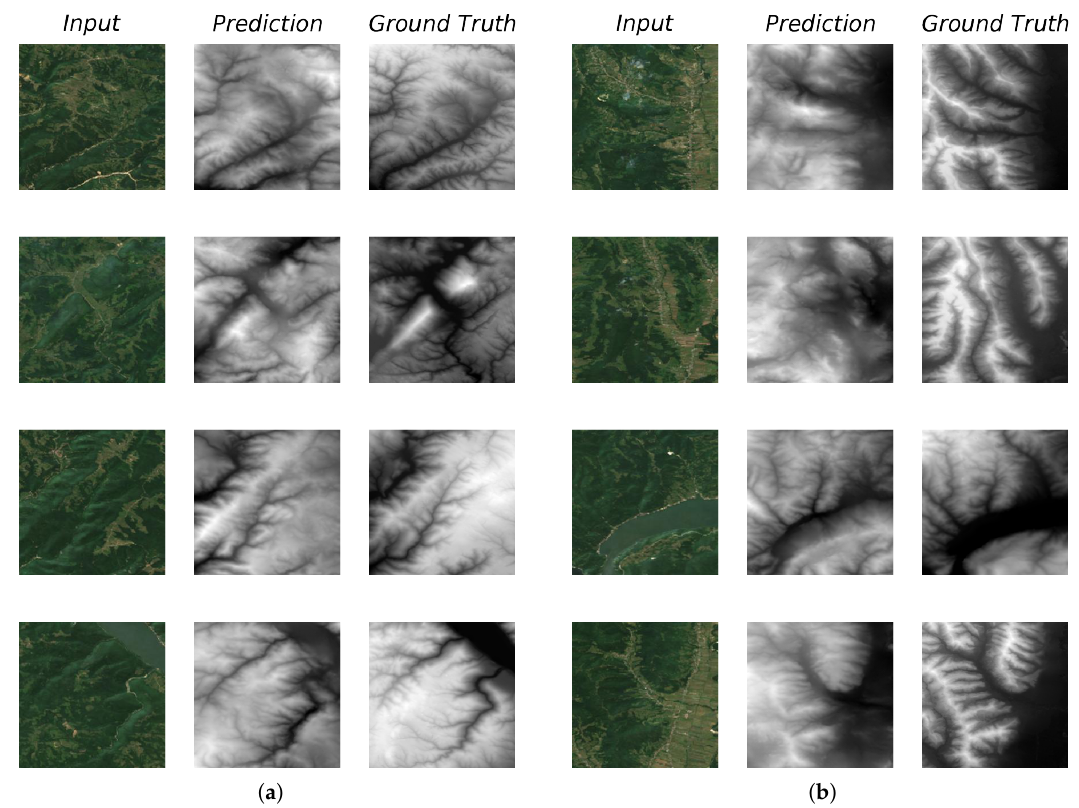
Figure 8. The generator’s results on previously unseen testing data. ( a ) In most cases it proves to have learned to capture the underlying relation between satellite imagery and DEMs, producing sharp results. ( b ) Even when reconstructions are poor, the model does not collapse to the easy solution of producing blurry results to approximate the result with minimum error, but manages to generate plausible representations in terms of DEM structure. Note that we used our data augmentation technique (Section